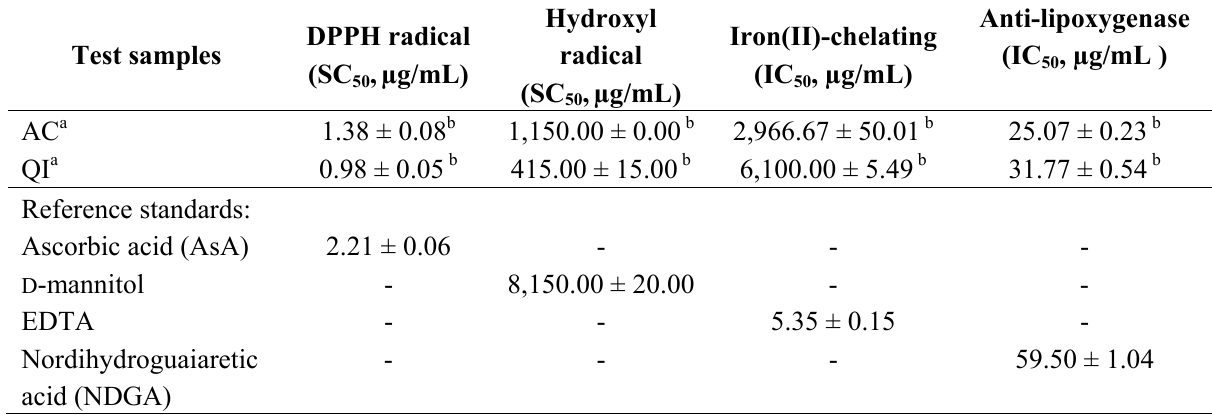
Table 1. The concentration giving 50% inhibition of DPPH radical, hydroxyl radical, iron(II) chelating capacity and lipoxygenase activities of test samples and standard references. The values represent mean ± S.E.M. (n =